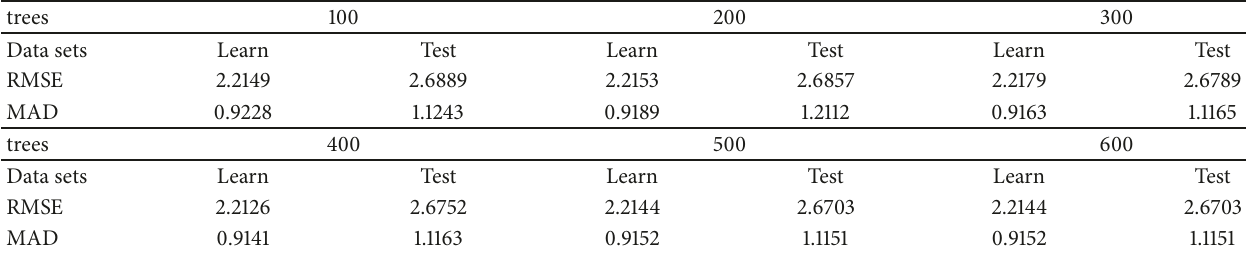
Table 4: 10-fold cross-validation errors with a different number of trees in the forest.